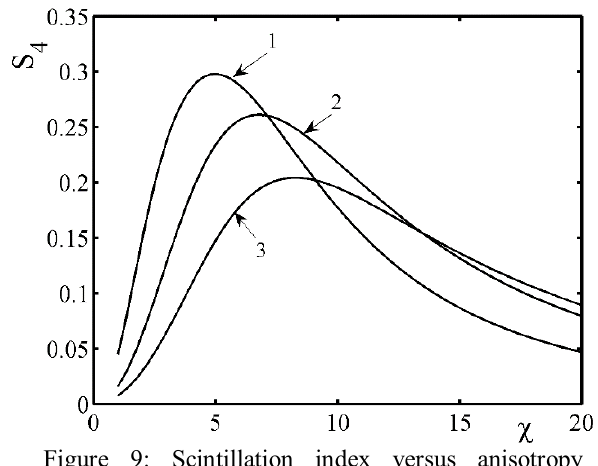
Figure 9: Scintillation index versus anisotropy coefficient for different parameter .